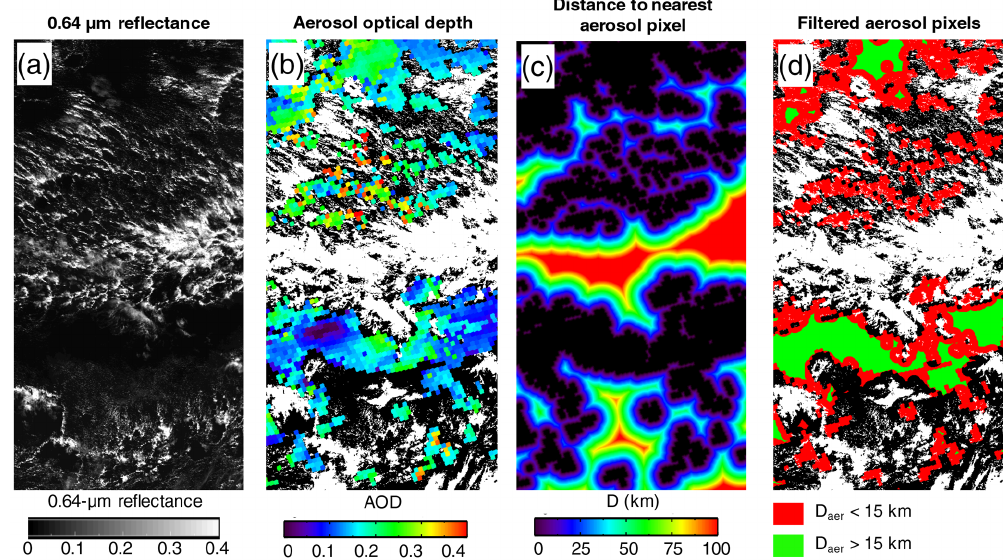
Figure 1. (a) Satellite image of the visible reflectance at 0.64µm from part of an AATSR orbit (512 × 1000km 2 ) on the 20 June 2008 over the ocean off the west coast of Africa. (b) Coinciding cloud mask (white) and aerosol optical depth (rainbow) retrieved using ORAC and (c) distance from each pixel to the nearest aerosol retrieval. (d) Aerosol retrievals that are located within 15km of a cloud are considered contaminated (red), while those farther away than this are considered valid (green).